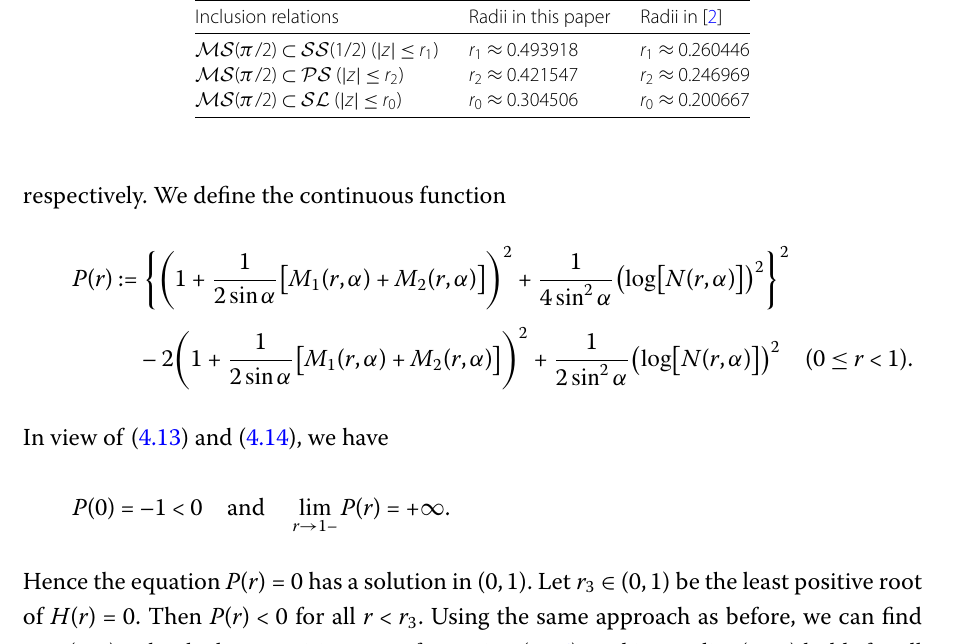
Table 1 The radii of inclusion relations Inclusion relations Radii in this paper Radii in